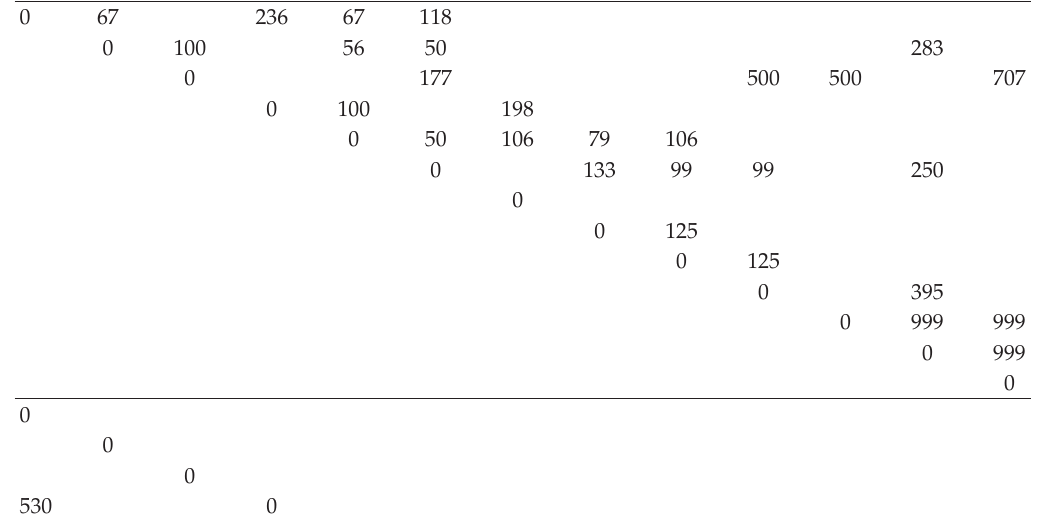
Table 2: Dissimilarity weight matrices W 11 ,W 12 ,W 22 of subgraphs